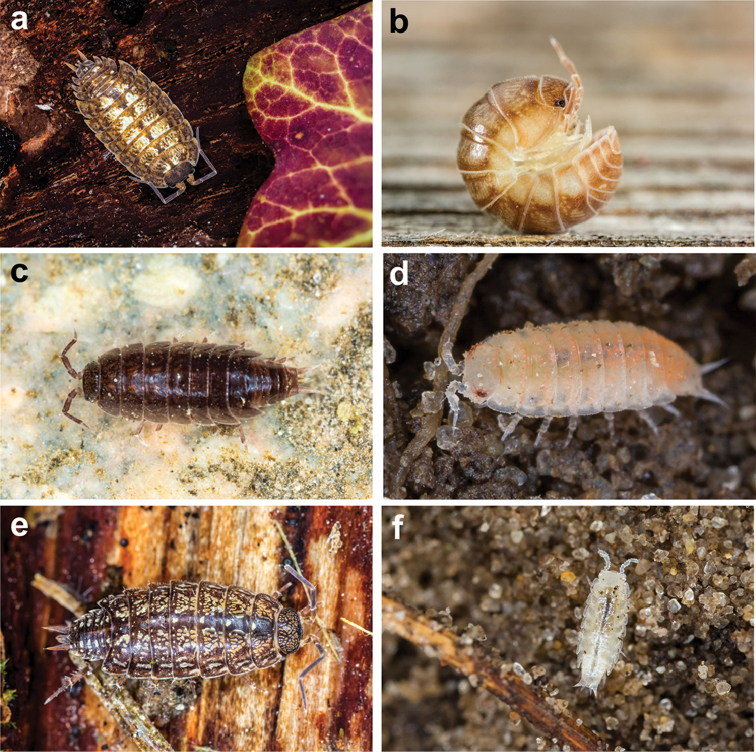
Six of the nine species added to this new checklist, aPorcelliomonticolabElumacaelatacHyloniscusripariusdTrichoniscoidessarsiePhilosciaaffinis and fMetatrichoniscoidesleydigii; photos: Gert Arijs.